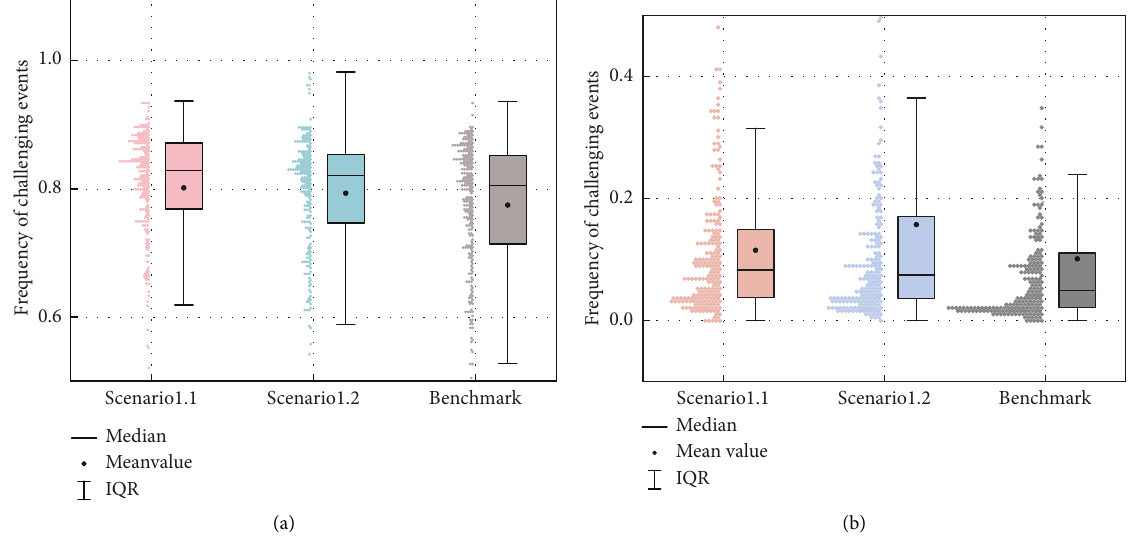
Figure 8: The boxplots for the first simulation: (a) the frequency of challenging events in each scenario when TTC is less than 2s and (b) the frequency of challenging events in each scenario when the headway is less than 1.5s.